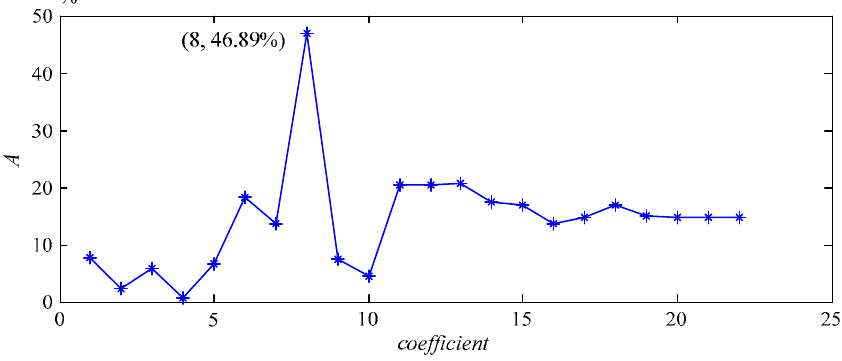
Figure 16. The comparison distribution diagram of FER based on the loose slipper fault signal.